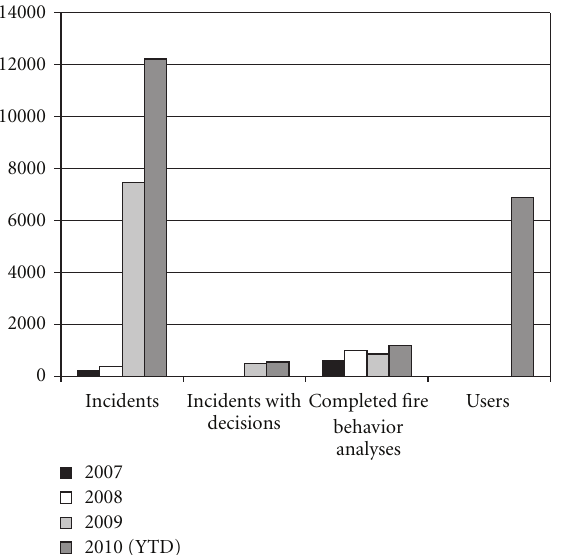
Figure 6: Usage statistics from 2007 to 2010 (YTD). Year to date includes data through November 20,